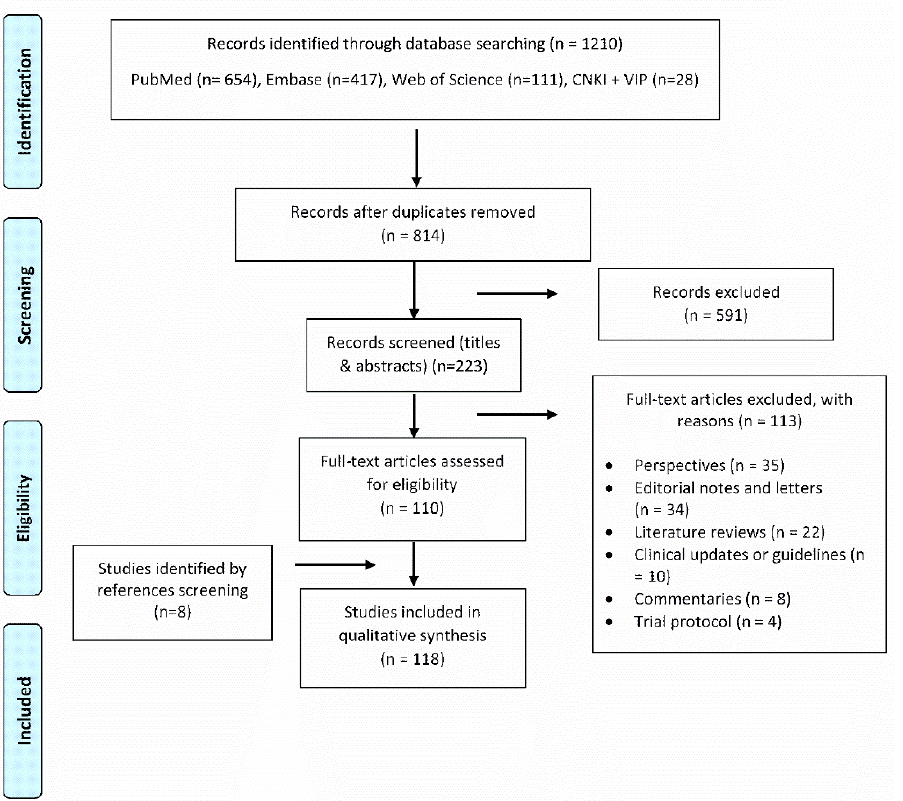
Figure 1. Prisma Figure 1. Prisma chart.